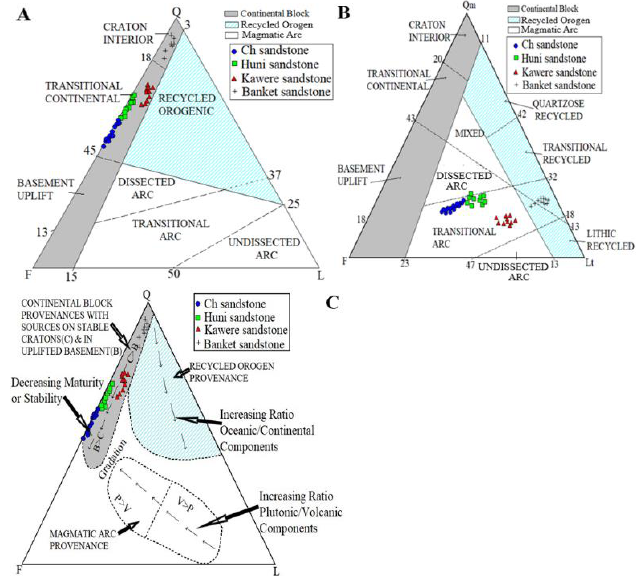
Figure 5: (A and B) are tectonic setting diagrams (A) Triangular QFL diagram showing mean framework modes of the sandstones investigated (Dickinson and Suzeck, 1979): (B) QmFLt diagram showing the mean framework modes for the sandstones investigated C) QLF plot of sediment maturity (Dickinson and Suzeck,